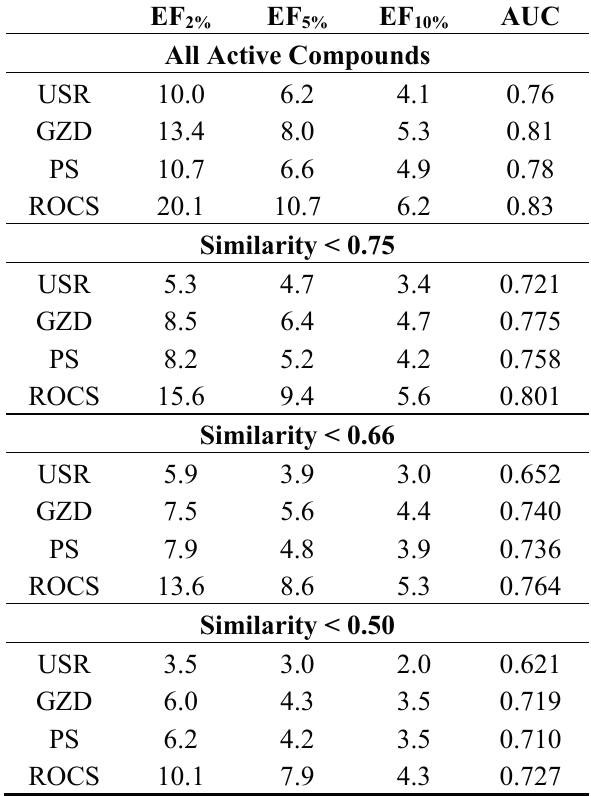
Table 3. Enrichment factors at 10%, 5%, and 2% and AUC values of each method after removing similar active compounds from the dataset.